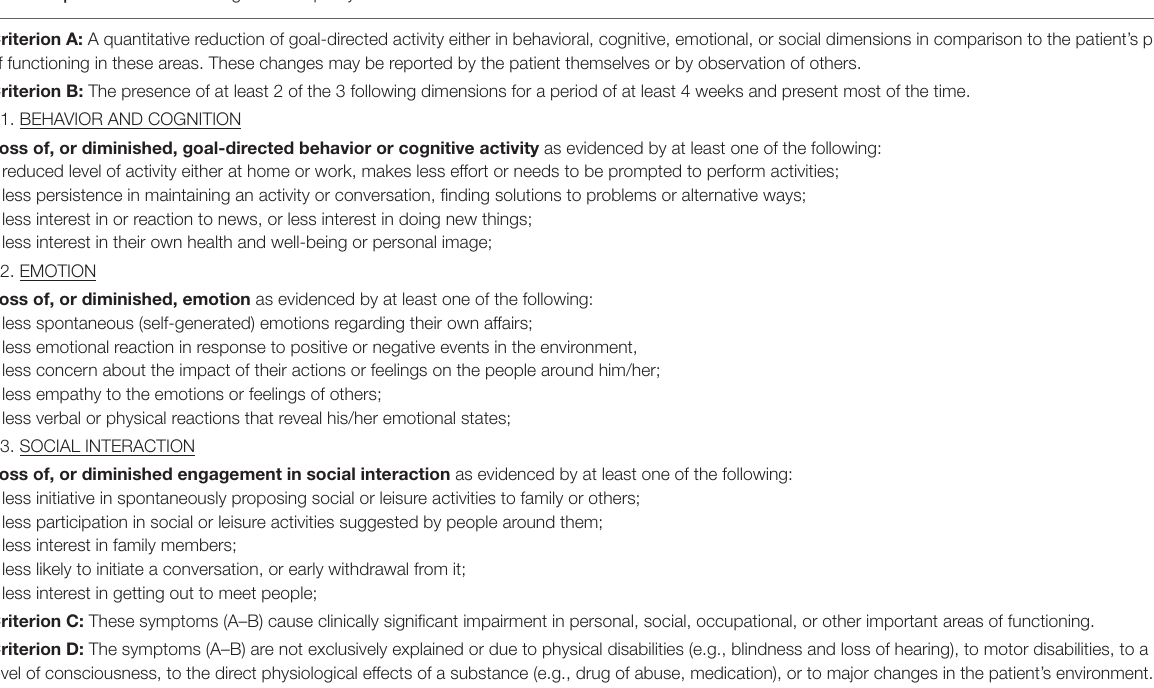
TABLE 2 | Criteria for clinical diagnosis of